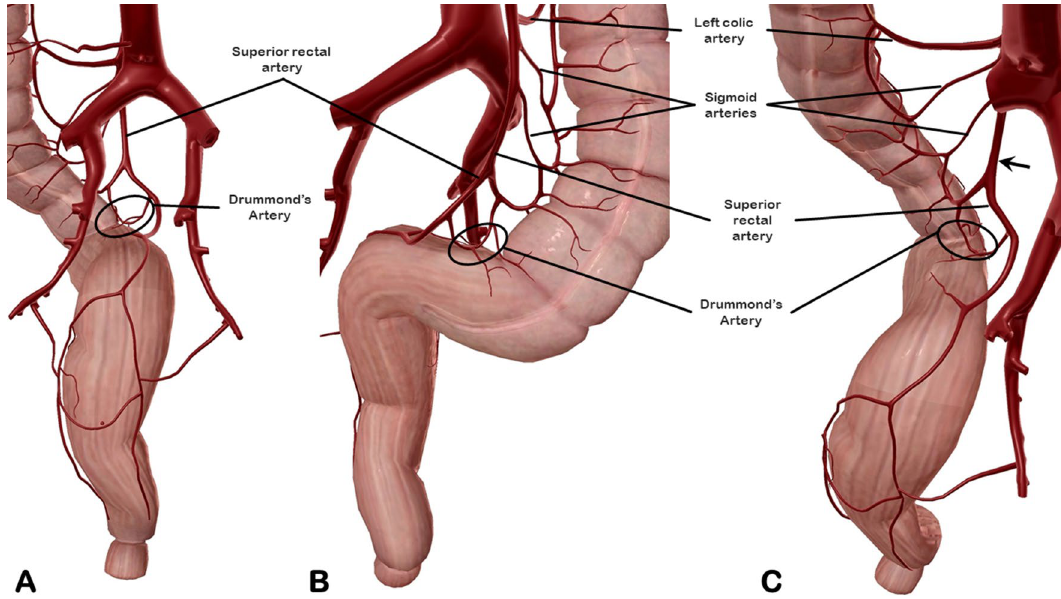
Figure 3. Identification of the Drummond’s artery in back ( A ), front ( B ), and back-high views ( C